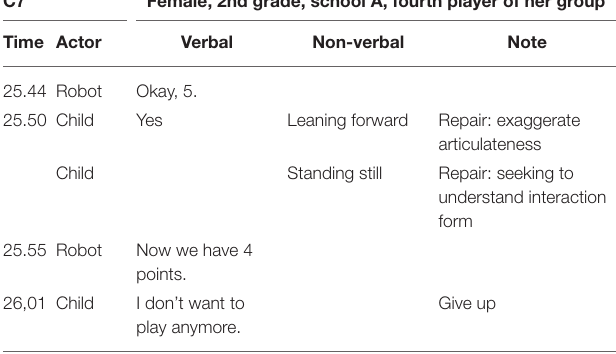
TABLE 5 | Excerpt for